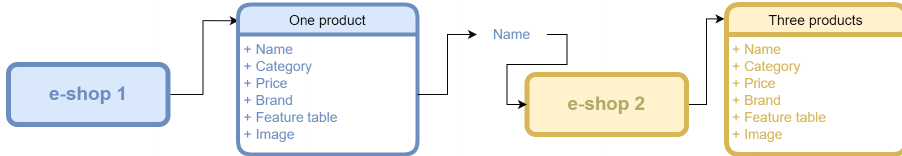
Figure 3. Information extraction process.